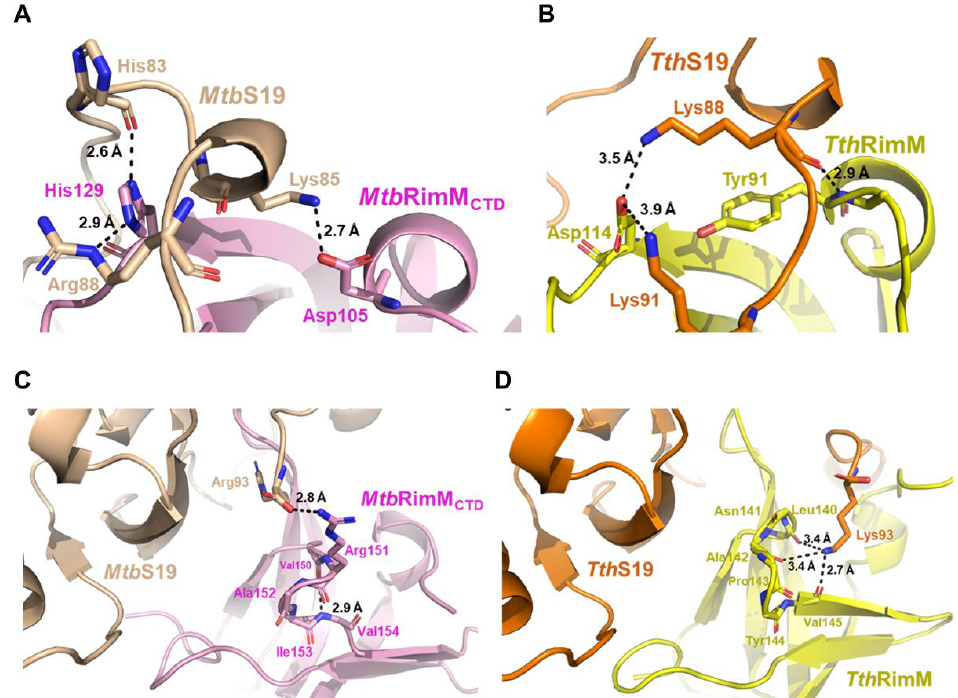
Figure 9. Comparison between the docking model of Mtb RimM CTD –S19 complex and the crystal structure of Tth RimM–S19 complex. ( A , B ) Illustration of the stabilized short helix located in the long C-terminal loop of S19 and nearby residues within the docking model of Mtb RimM CTD –S19 ( A ) or the crystal structure of Tth RimM–S19 (PDB: 3A1P) ( B ). Atom distances are shown beside the corresponding black dashed lines. ( C , D ) S19 C-terminal residue Arg93 involved in the interaction of Mtb S19 with Mtb RimM CTD ( C ) or Lys93 in that of Tth S19 with Tth RimM ( D ). Atom distances are shown beside the corresponding black dashed lines.